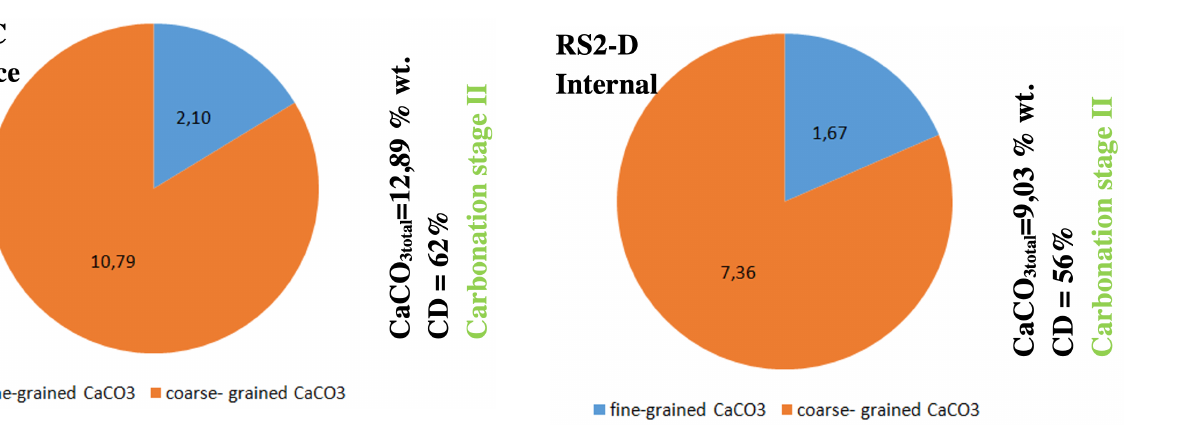
Figure 13. The amount of CaCO 3 (% wt.) in the internal layer of the protected concrete sample RS2-D by PRC.